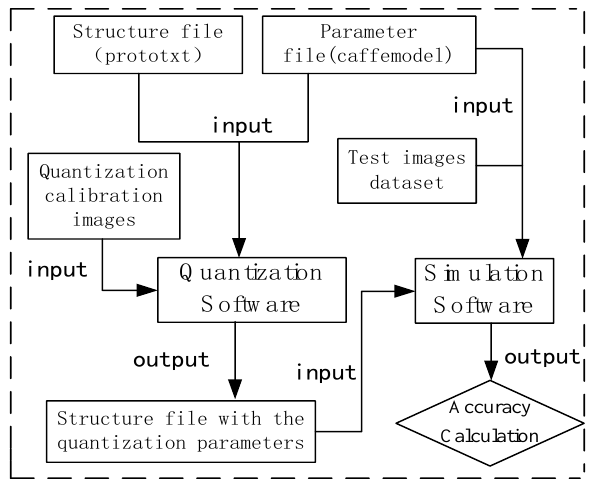
Figure 4. Inputs and outputs of quantization and simulation software.